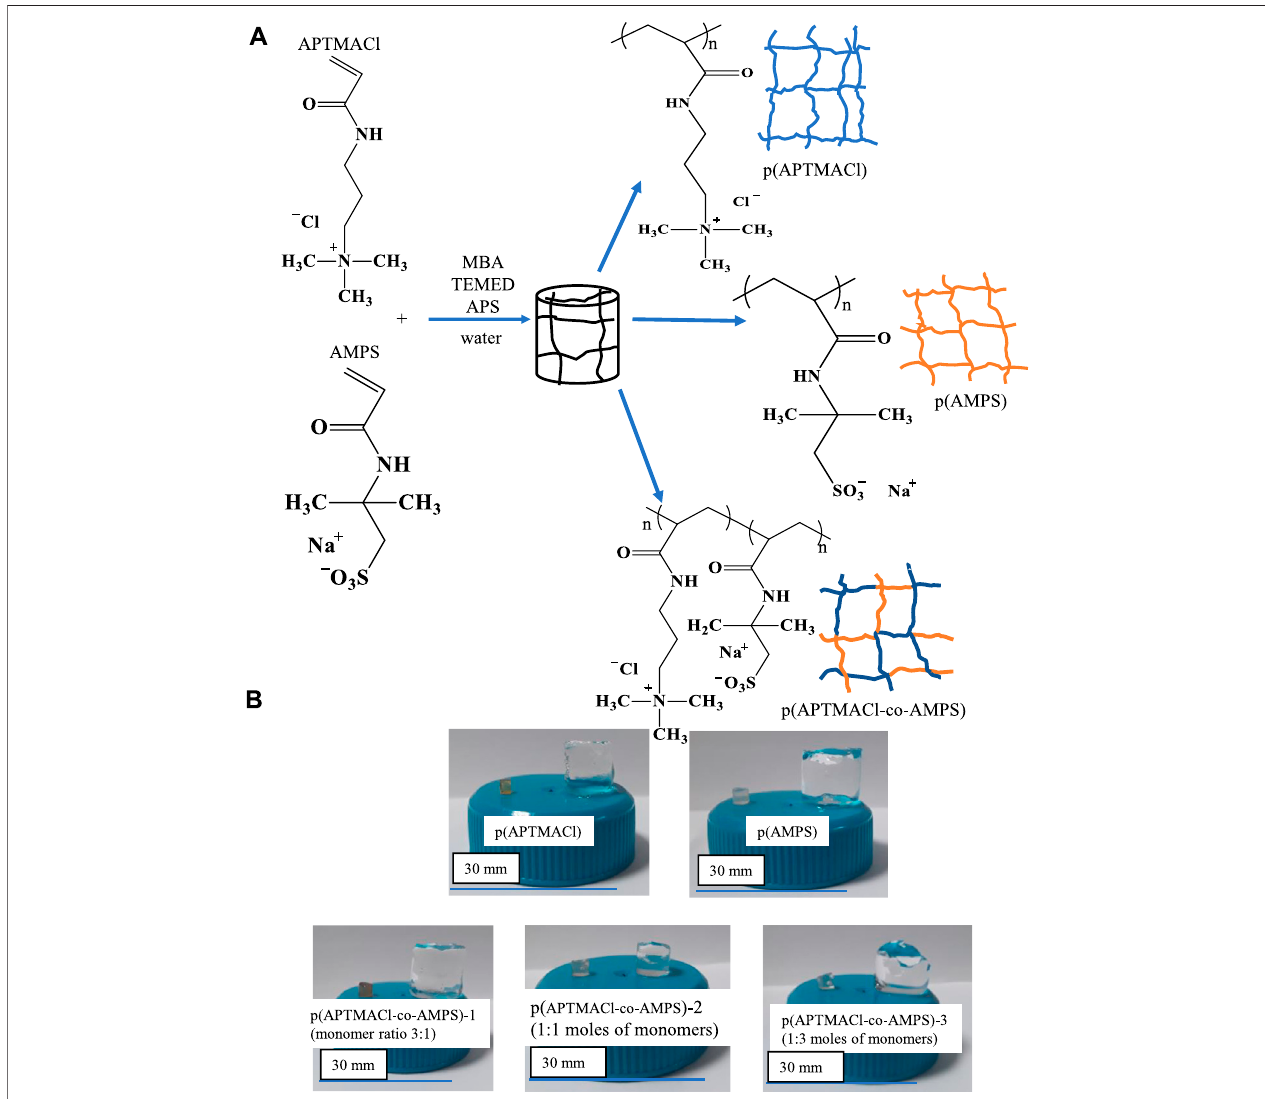
FIGURE 1 | (A) the schematic presentation of the preparation, and (B) digital camera images of cationic p (APTMACl), anionic p (AMPS), and amphoteric p (APTMACl-co-AMPS)-1, p (APTMACl-co-AMPS)-2, and p (APTMACl-co-AMPS)-3 hydrogels.